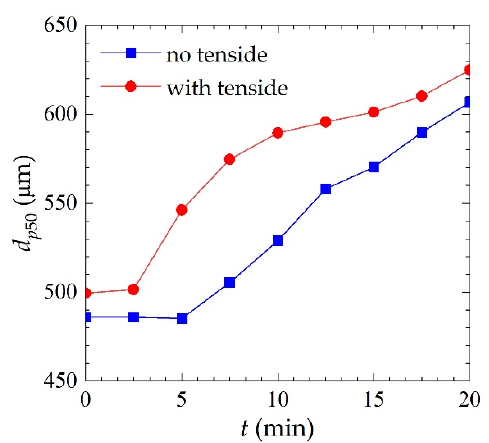
Figure 4. Temporal evolution of the median particle diameter d p 50 .